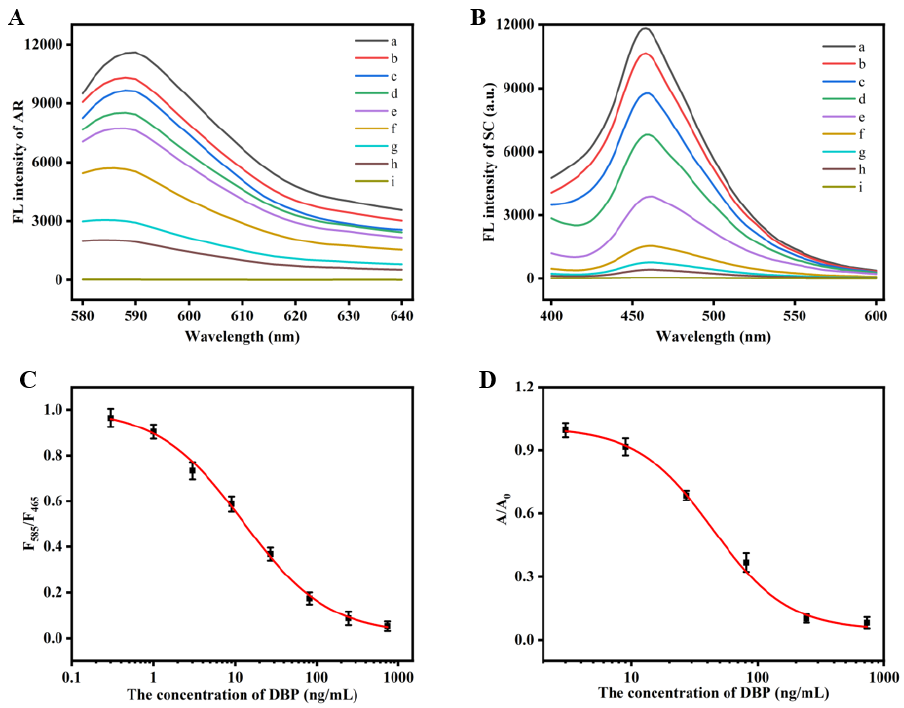
Figure 4. Fluorescence spectra of AR ( A ) and Sc ( B ) in the presence of increasing DBP concentrations. ( C ) Calibration curve of ratiometric fluorescence values (F 465 /F 585 ) versus different concentrations of DBP (The error bars are obtained via three replicates) and ( D ) the standard curve of traditional indirect competitive ELISA for DBP under optimized conditions.